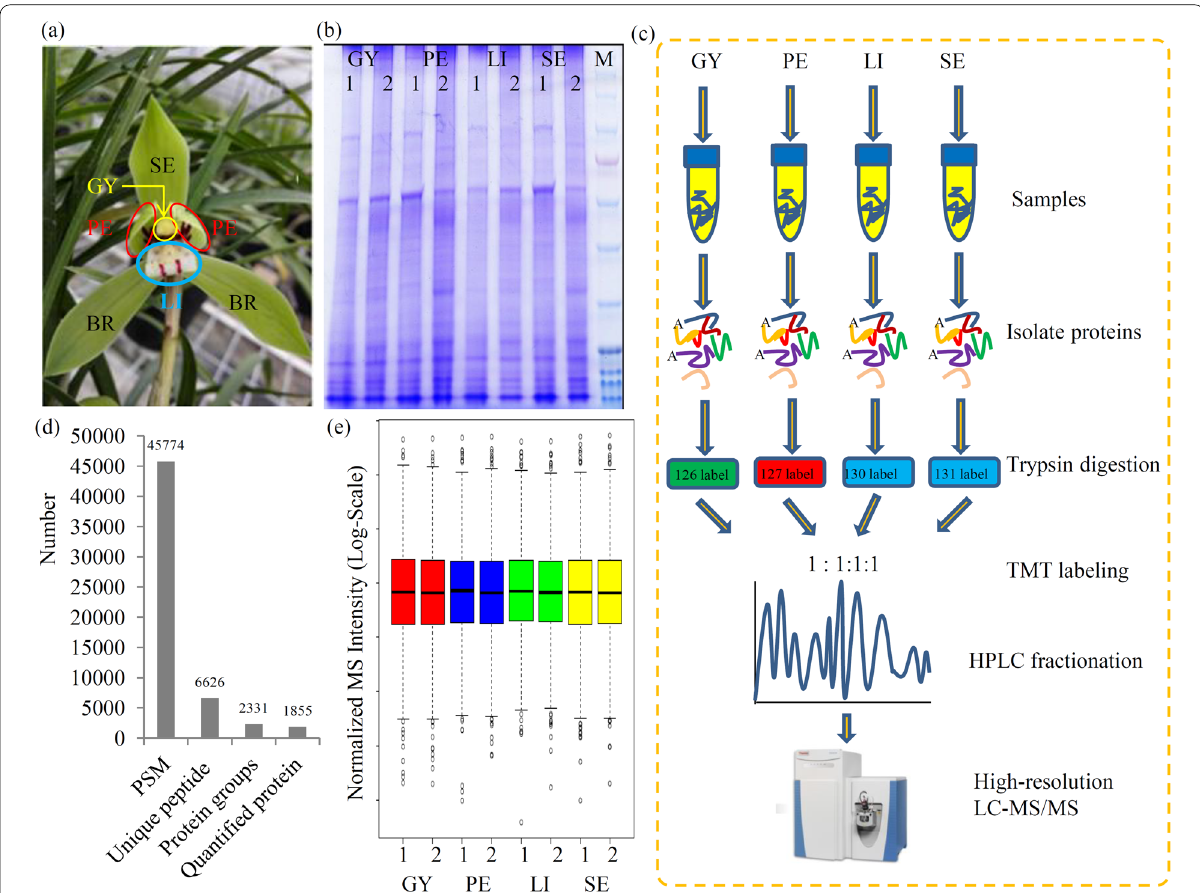
Fig. 1 Overview of the proteomic data. a A picture of typical Cymbidium goeringii flower. Samples from different floral organs, including gynostemium (GY): petal (PE), lip (LI), and sepal (SE) are showed in the picture. b The SDS-PAGE Gel electrophoretic graph for the samples from four different organ groups, including GY, PE, LI, and SE. M: protein marker. c Experimental strategy for the quantitative analysis of proteomes from four different floral organs. d Statistic results of protein identification. e Normalized MS